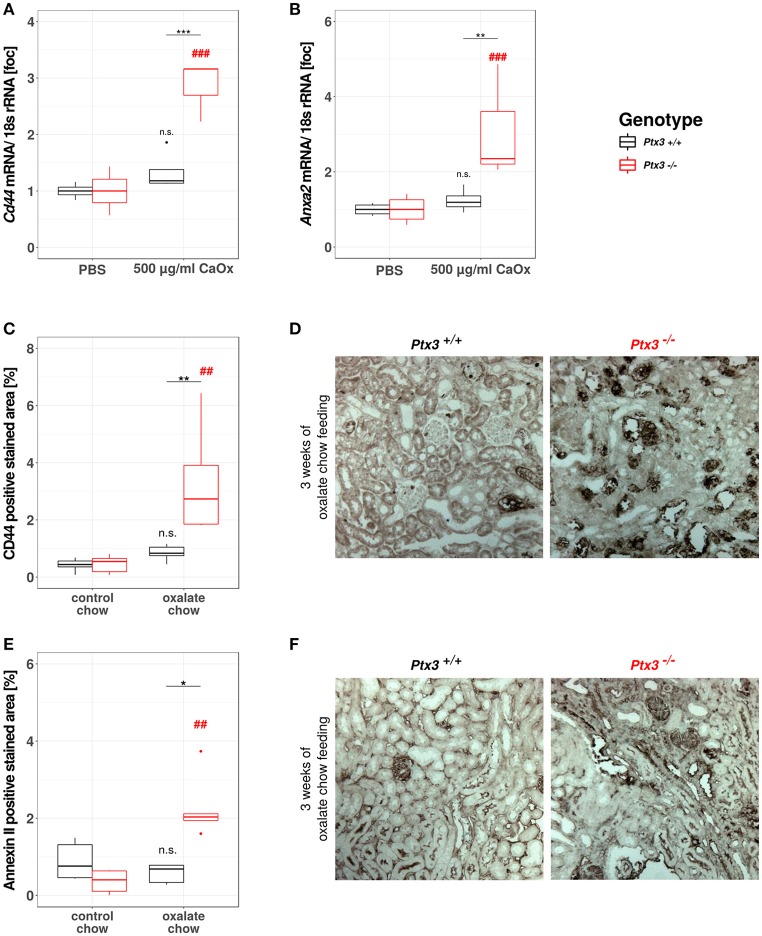
PTX3 abolishes crystal adhesion molecule expression in vitro and in vivo. (A,B) Primary murine proximal tubular cells were isolated from Ptx3+/+ and Ptx3−/− littermate mice with 3 weeks of age and stimulated with PBS and 500 μg/ml CaOx crystals, respectively (n = 4). Total RNA was isolated and transcribed to cDNA. Subsequent qPCR for (A) Cd44 and (B) AnxaII expression was conducted. (C–F)
Ptx3+/+ and Ptx3−/− female littermates (10–12 weeks of age) were fed with oxalate chow for 3 weeks and formalin kidney sections were stained for (C,D) CD44 and (E,F) Annexin II, respectively (n = 5). n.s., not significant; *p < 0.05, **p < 0.01, ***p < 0.001 vs. wild type and respective ## and ### vs. PBS as indicated.